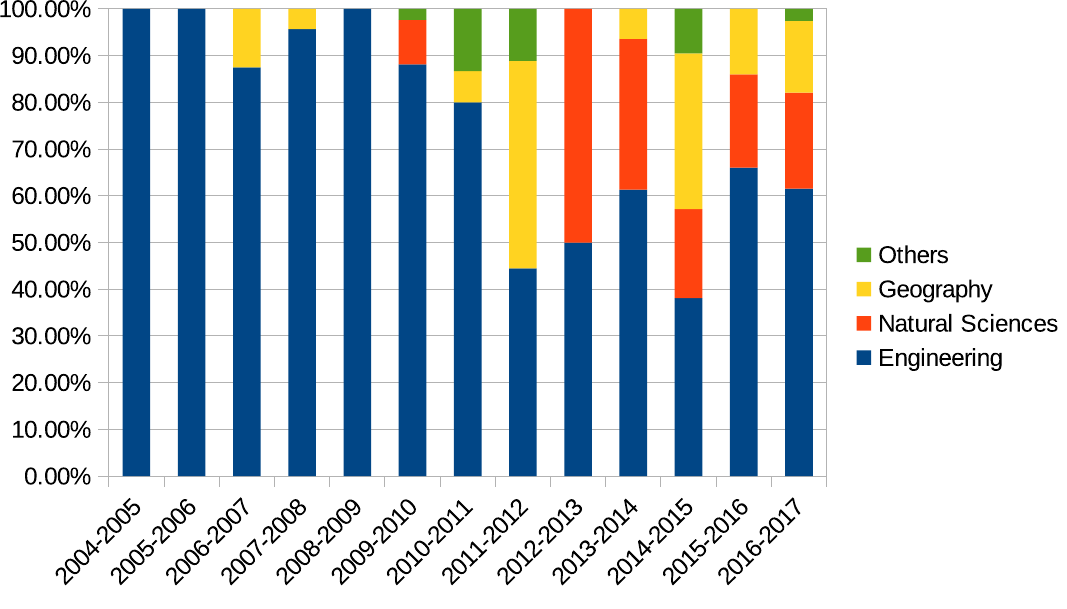
Figure 2. Percentage distribution with respect to fields of study for the GIS academic course offered at the DICCA; “Others” mainly denotes architecture and informatics